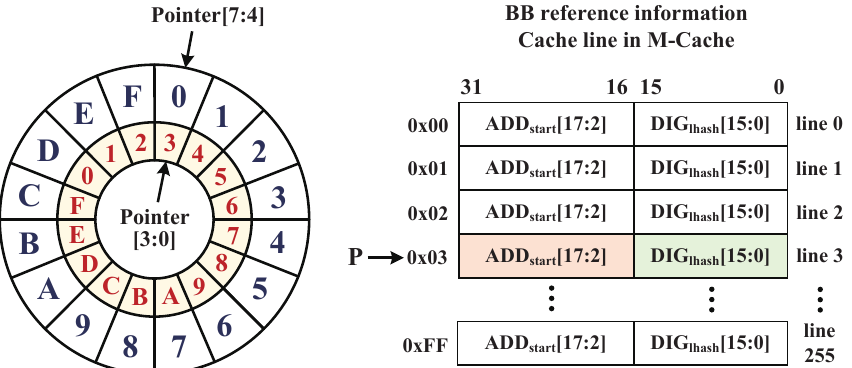
Figure 9. The M-Cache searching method and internal structure of the BB reference information